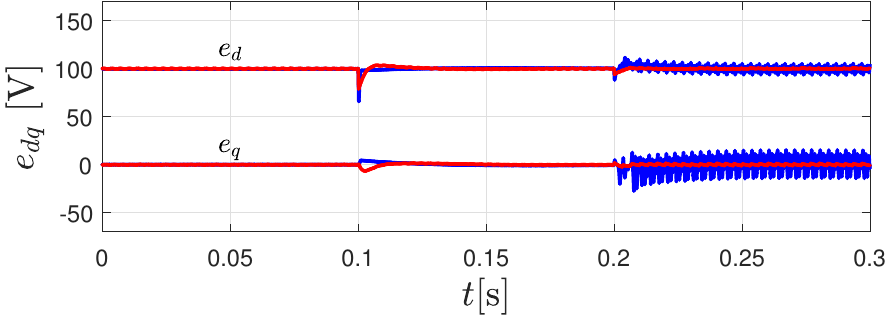
Figure 7. Voltage behavior in the Park’s reference frame, comparison between the proposed controller (in red) and the classic PI approach (in